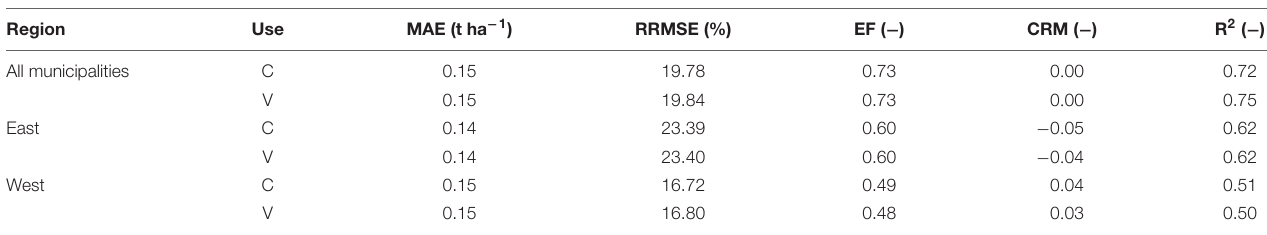
TABLE 2 | HADES performance in predicting official